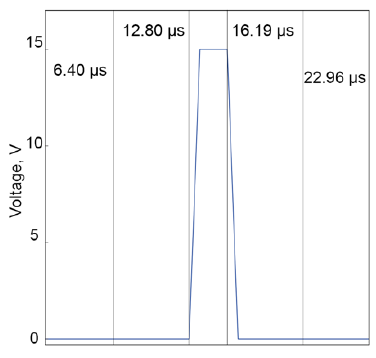
Figure A6. Waveform (voltage curve) of inkjet printing system.